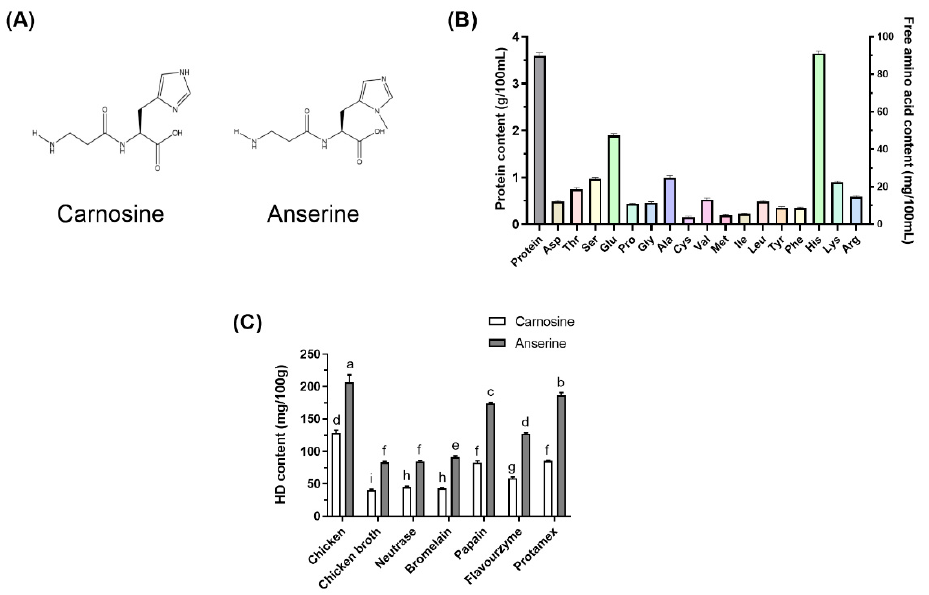
Figure 1. The structure of CAR and ANS ( A ). The protein and free amino acid content in CB ( B ). The effect of different enzymatic hydrolytic treatments on the HD content in the CB ( C ). Different letters indicated significant differences among the groups ( p < 0.05).